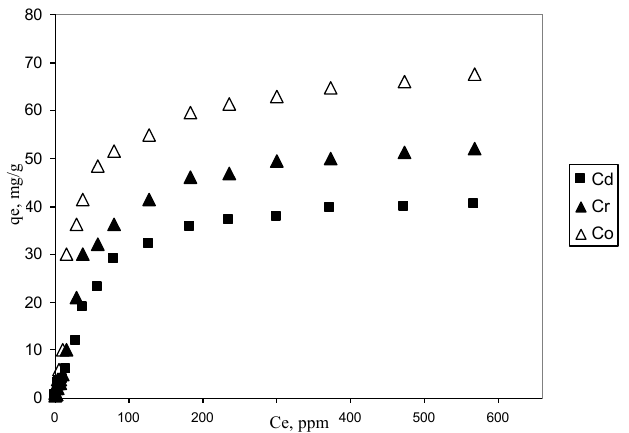
Figure 2. ACOP adsorbent dosage effect on Cr 3+ , Cd 2+ and Co 2+ removal Conditions: C 20 mg·L –1 ; time of contact, 60 min; pH 5.0 and temperature, 298 K.